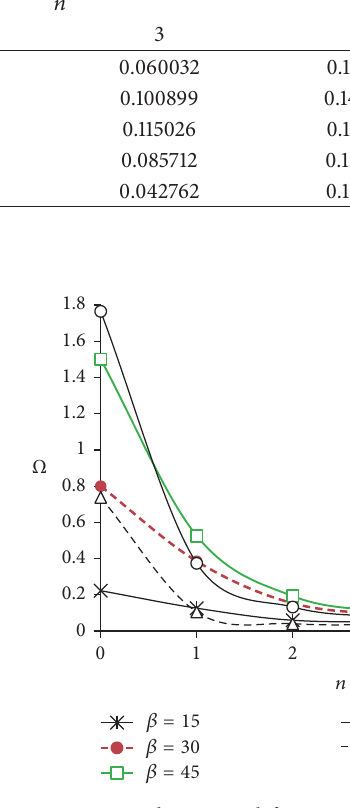
Figure 2: Nondimensional frequency variation of fixed PMMA/ CNT composite shell for 𝑉 ∗ CN = 0